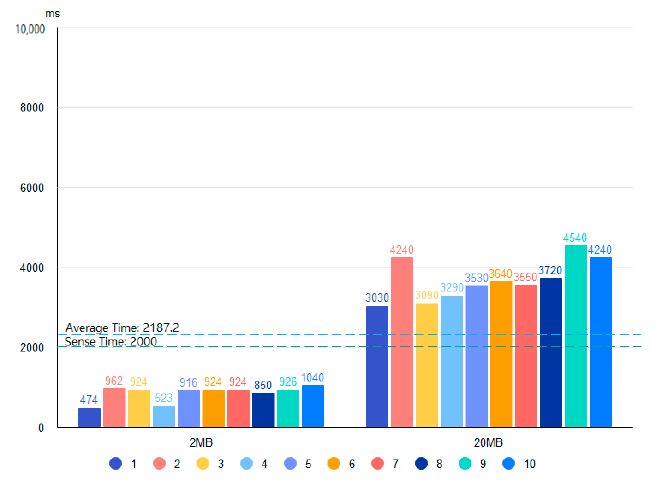
Figure 10. Time test of Pattern I.